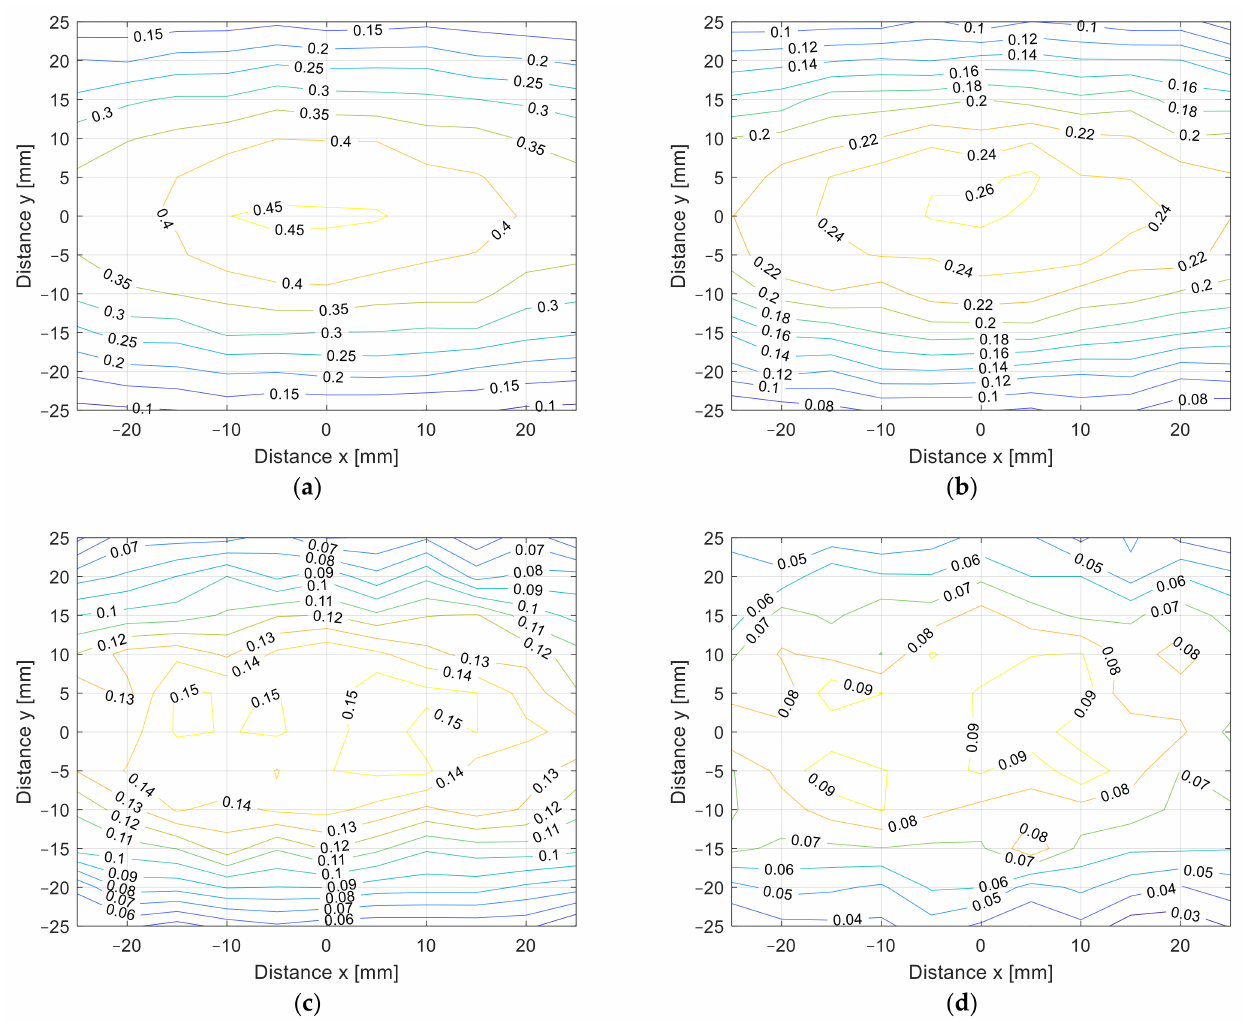
Figure 15. x - y coupling coefficient measurement of planar DD coils (contour plot). ( a ) At z = 10 mm,